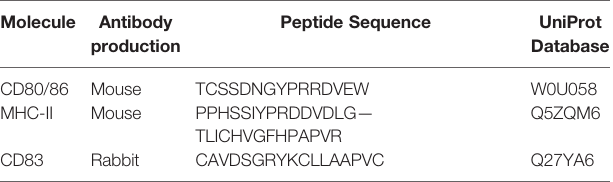
TABLE 3 | Primary antibodies against cell-surface markers of Atlantic salmon. Molecule Antibody